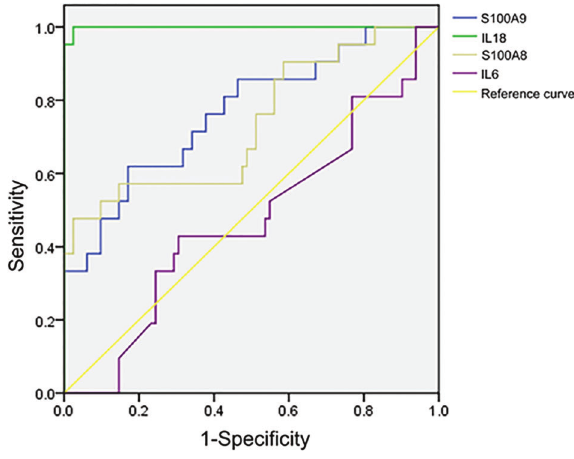
Figure 2. ROC curves of S100A9, IL-18, S100A8, and IL-6 for predicting systemic-onset juvenile idiopathic arthritis